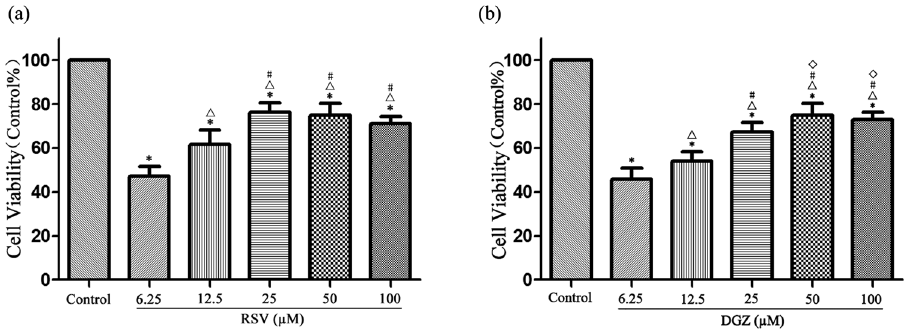
Figure 3: Comparison of the cell viability of various concentrations rosuvastatin and dapagli fl ozin pretreatment the H/R - induced H9C2 cells using a CCK - 8 assay ( mean ± SD, n = 6 ) . * p < 0.001 compared with the control group; # p < 0.01 compared with the 6.25 µM group; △ p < 0.01 compared with the 12.5 µM group; ◇ p < 0.01 compared with the 25 µM group. RSV: rosuvastatin; DGZ: dapagli fl ozin. Control: control